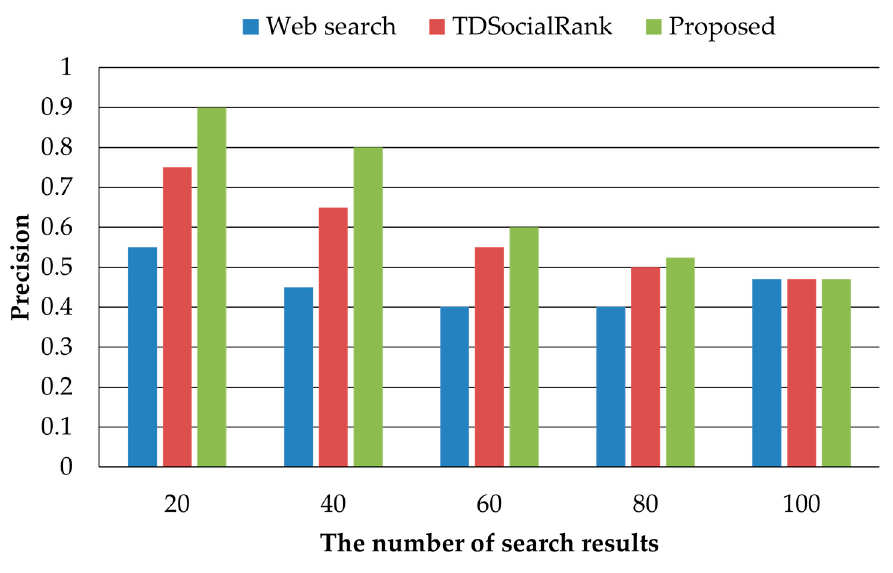
Figure 4. Precision.